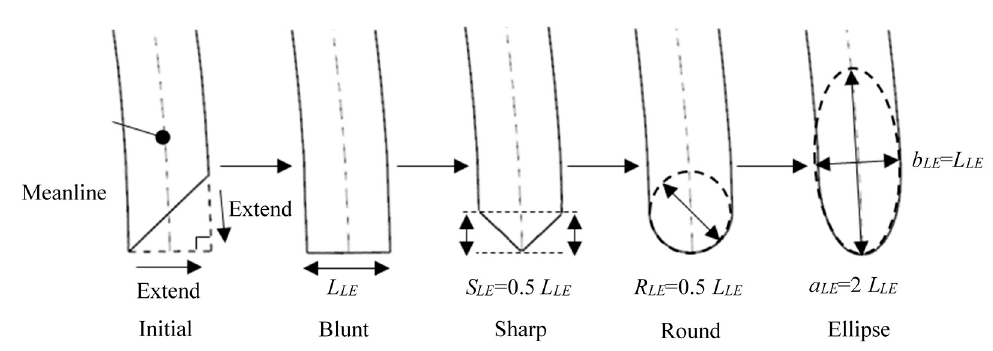
Figure 7. Schematic map of leading-edge reshaping based on the initial impeller.